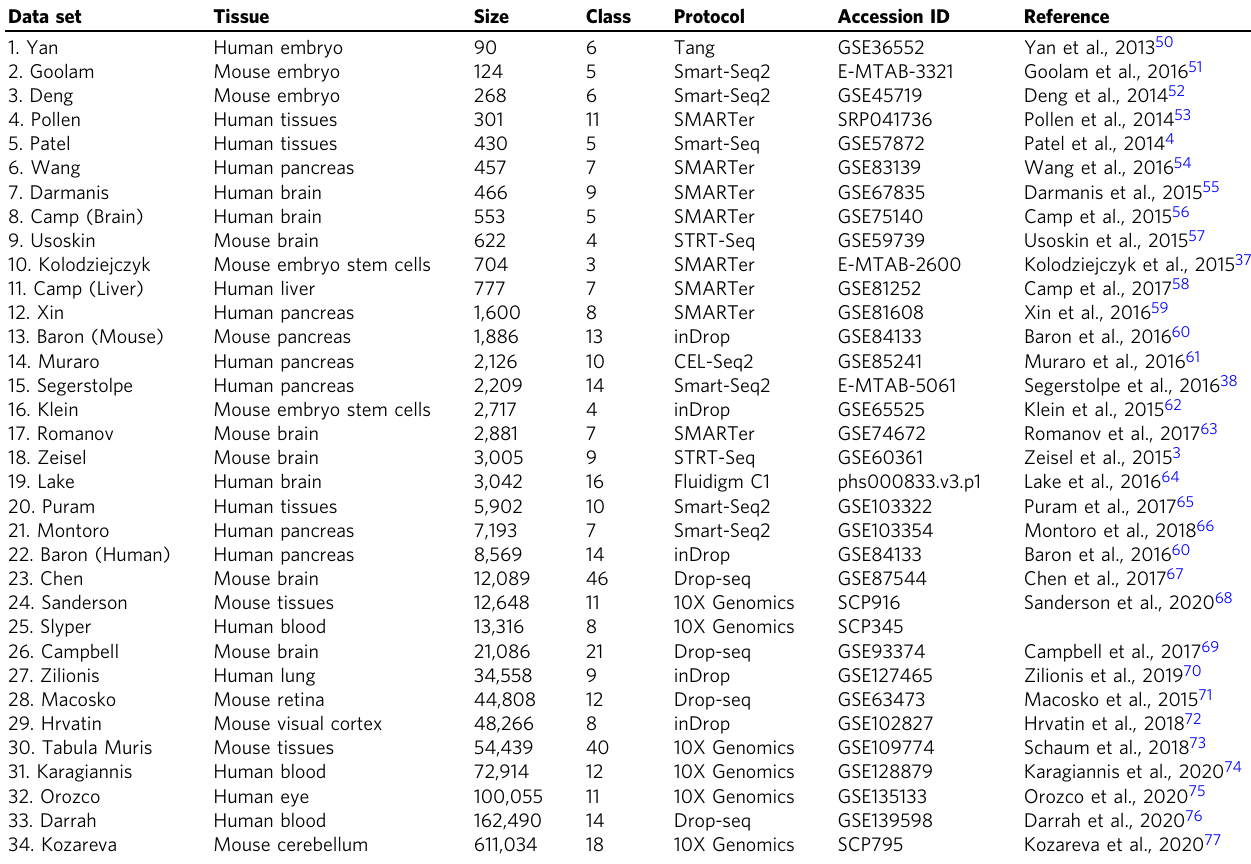
Table 1 Description of the 34 single-cell data sets used to assess the performance of computational methods.